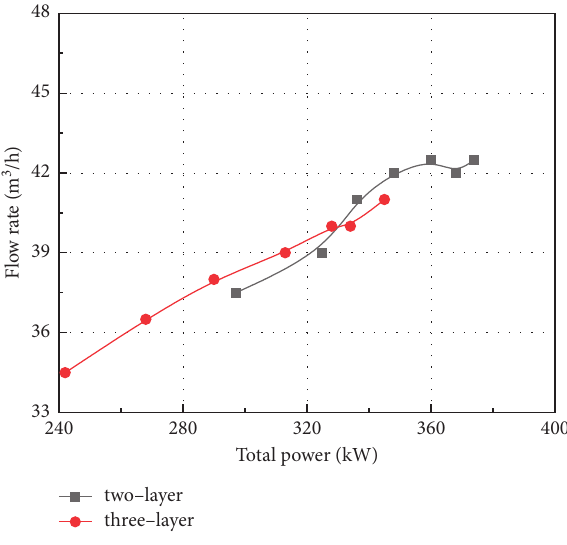
Figure 12: Variation of flow rate with THP.